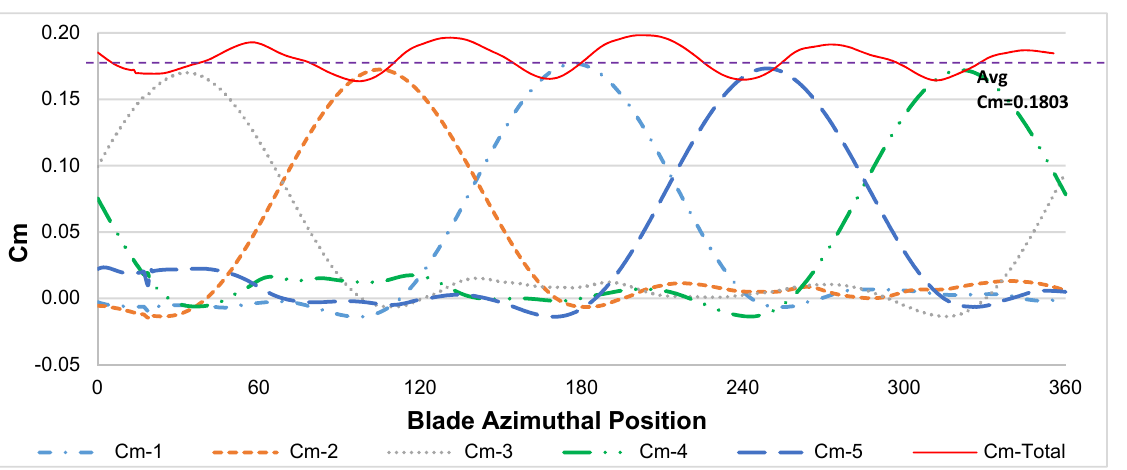
Figure 18. Turbine coefficient of the moment for individual blades and total turbine C m . The velocity profiles obtained using CFD simulation for the case with a river inflow rate of 1.5 m/s and turbine rotation rate of 44 RPM are depicted in Figure 19, while the vorticity distribution is shown in Figure 20.